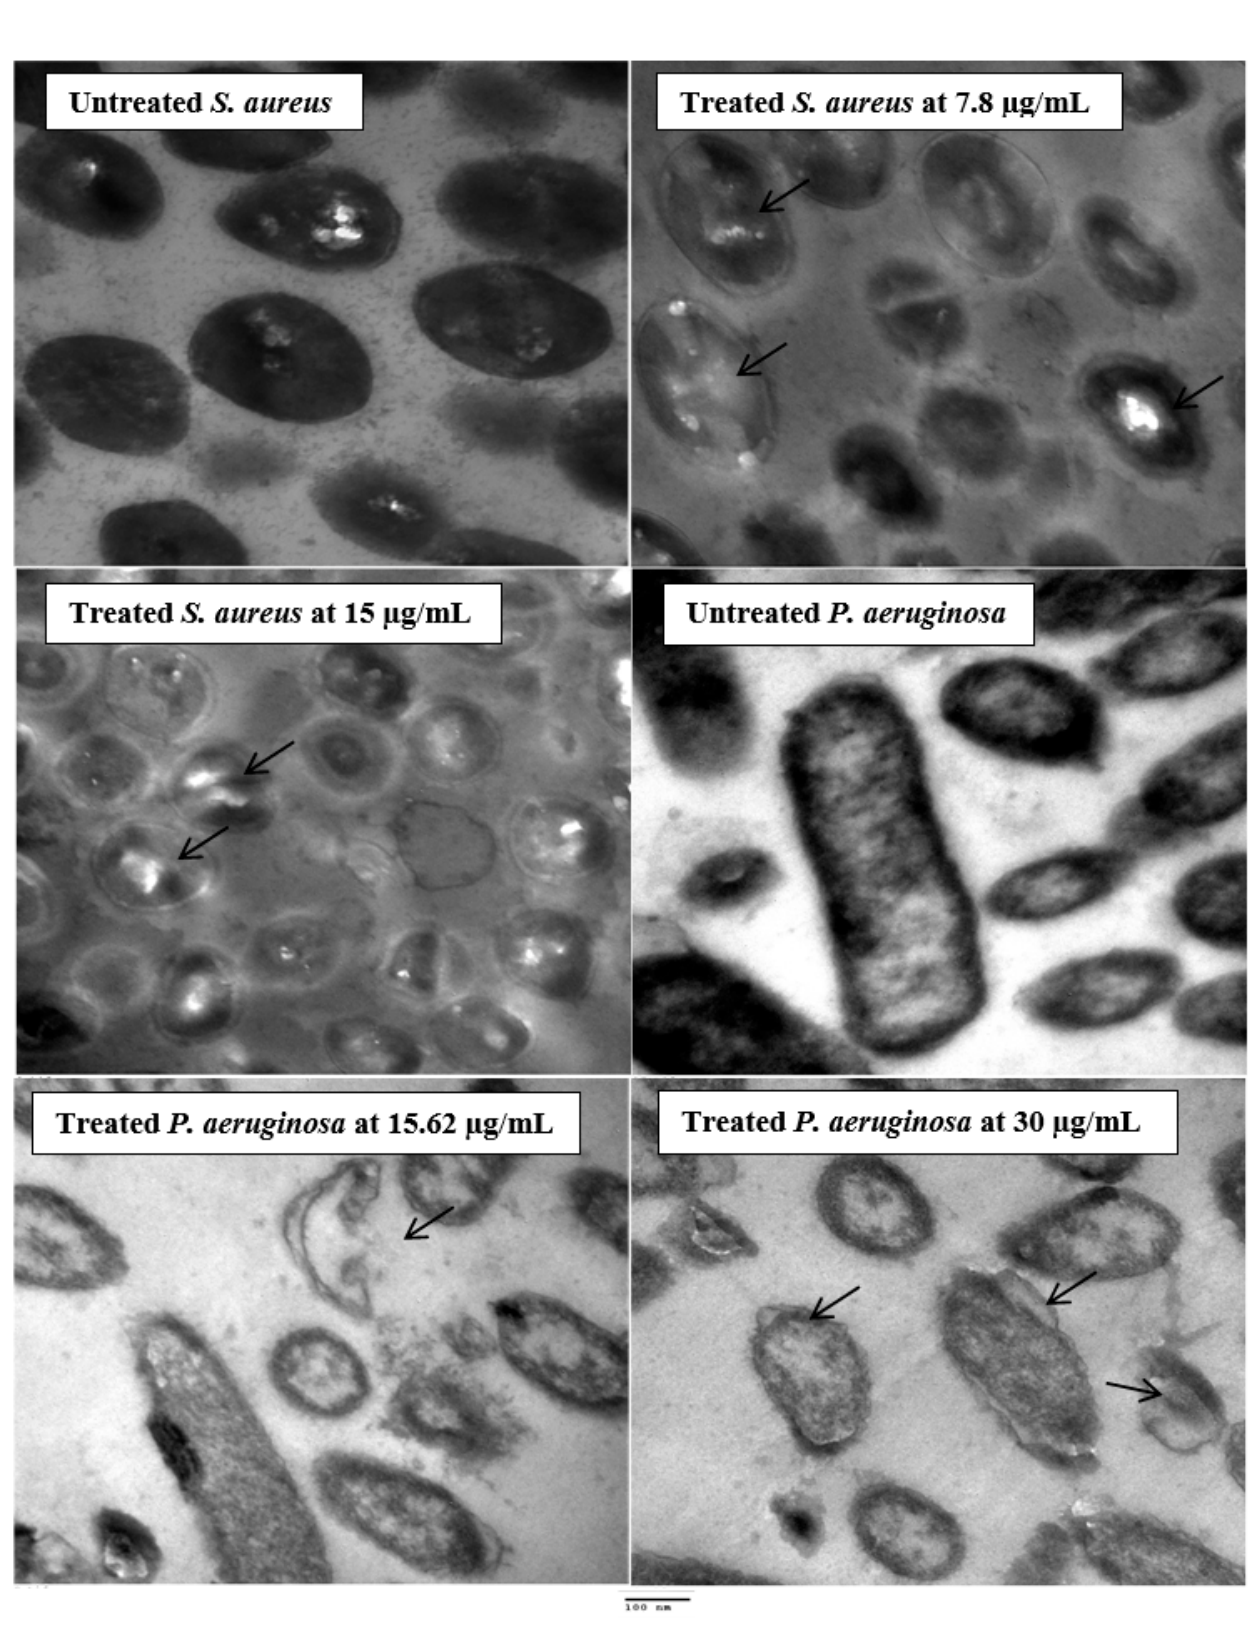
Figure 4. TEM micrographs of S. aureus and P. aeruginosa treated by latex. Scale Bar = 100 nm, 5000 ×.